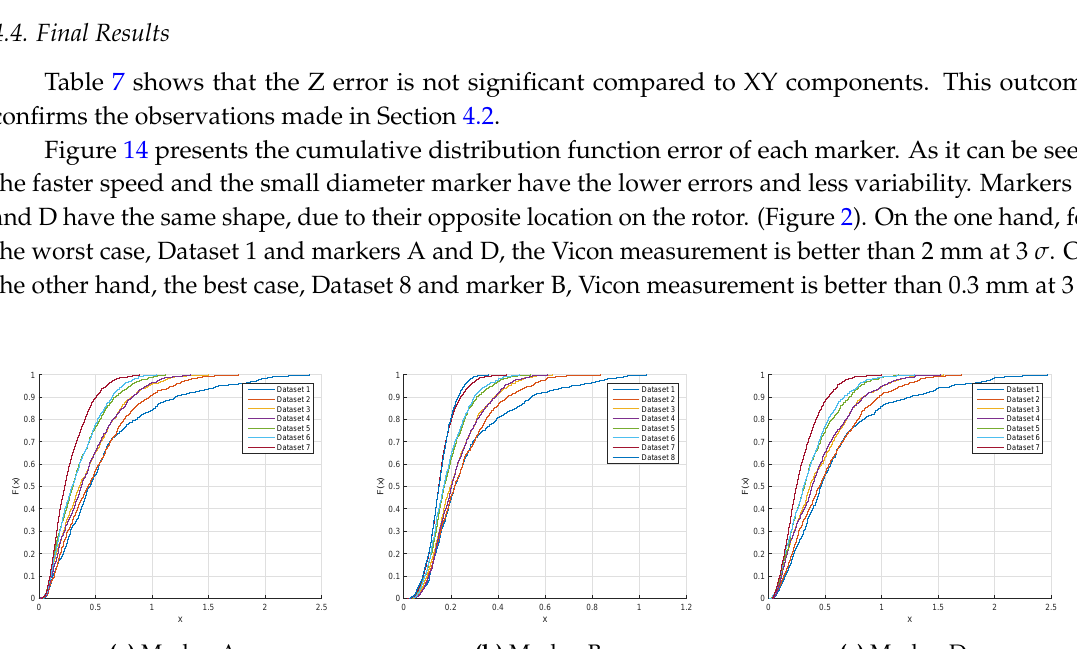
Figure 13. Error vs. linear speed for each dataset.